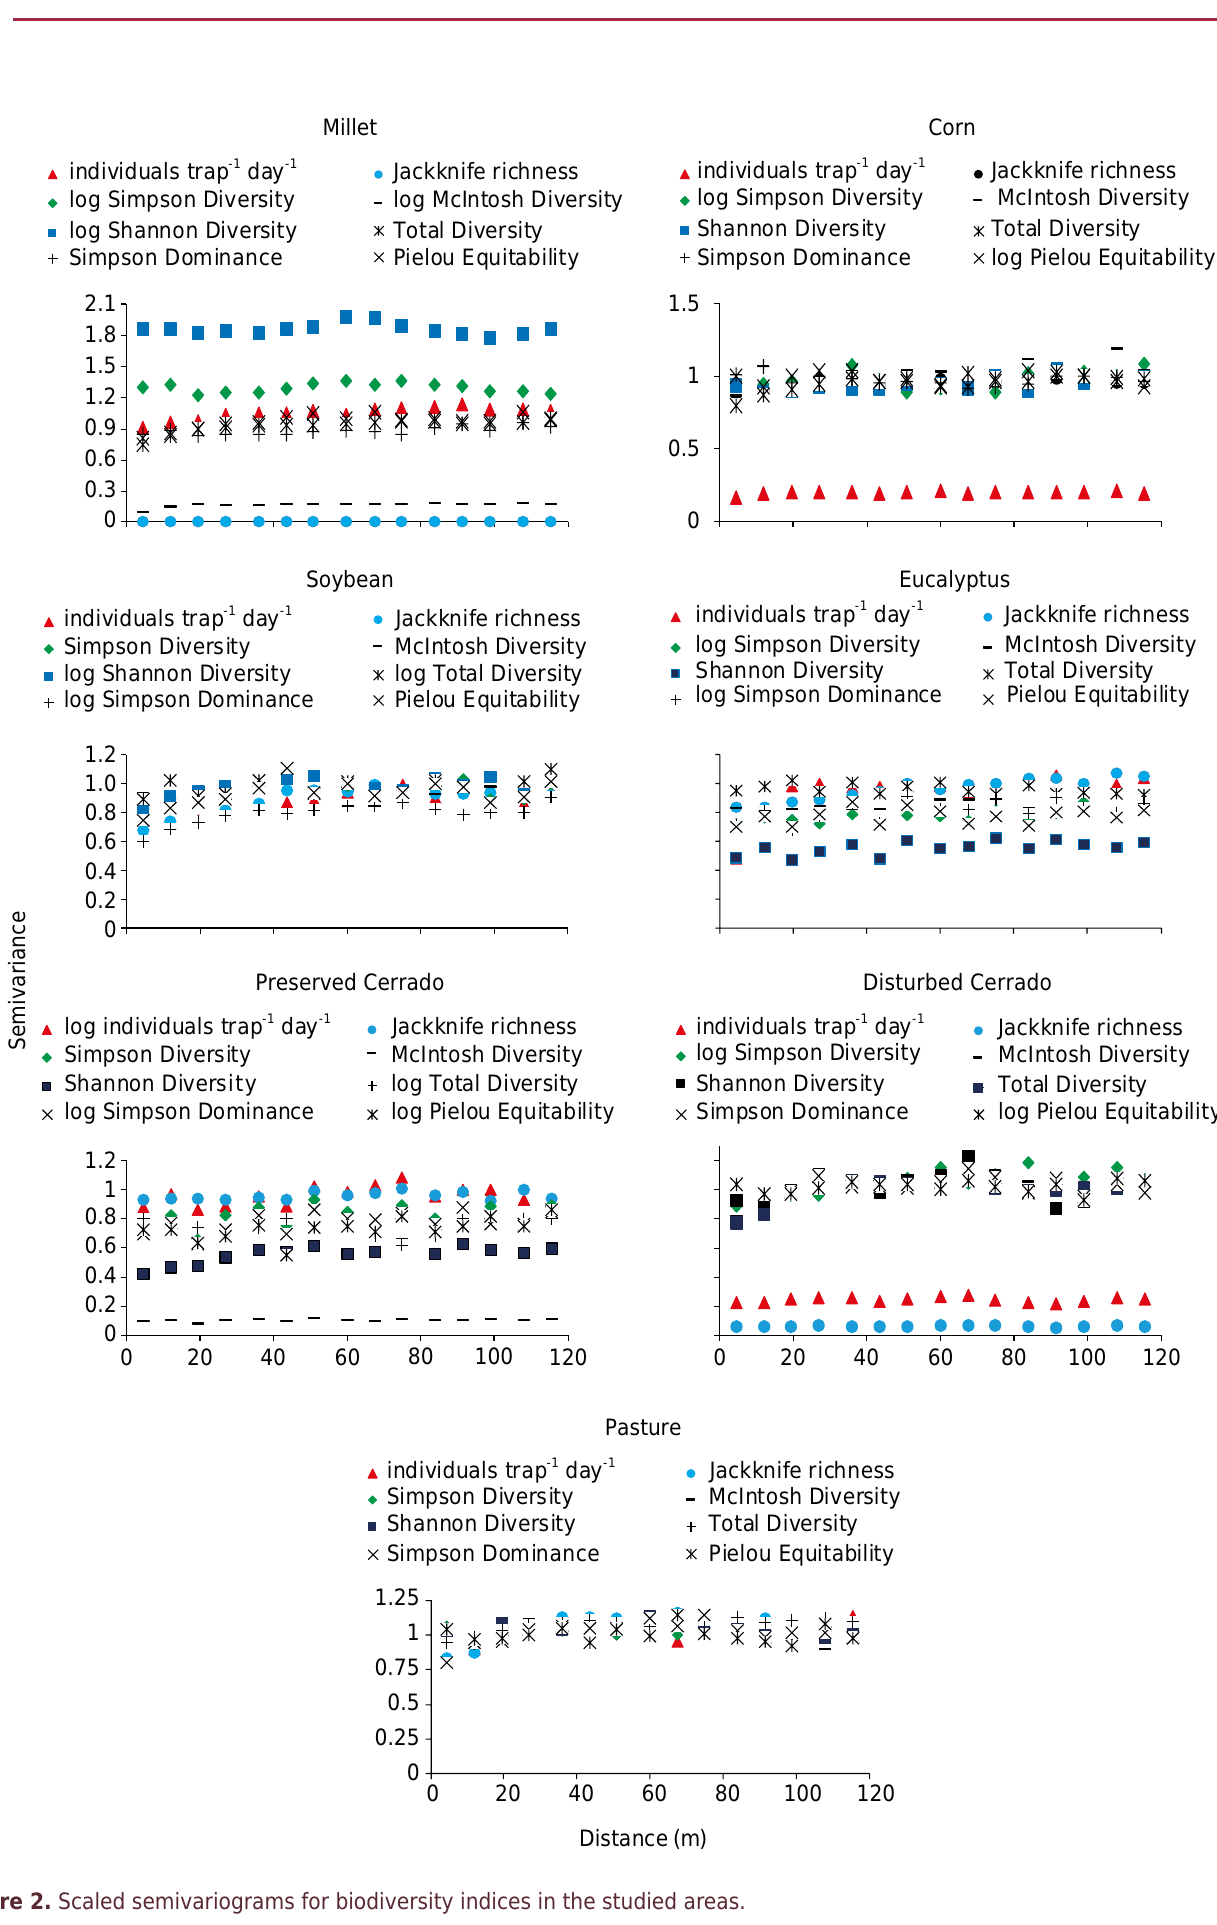
Figure 2. Scaled semivariograms for biodiversity indices in the studied